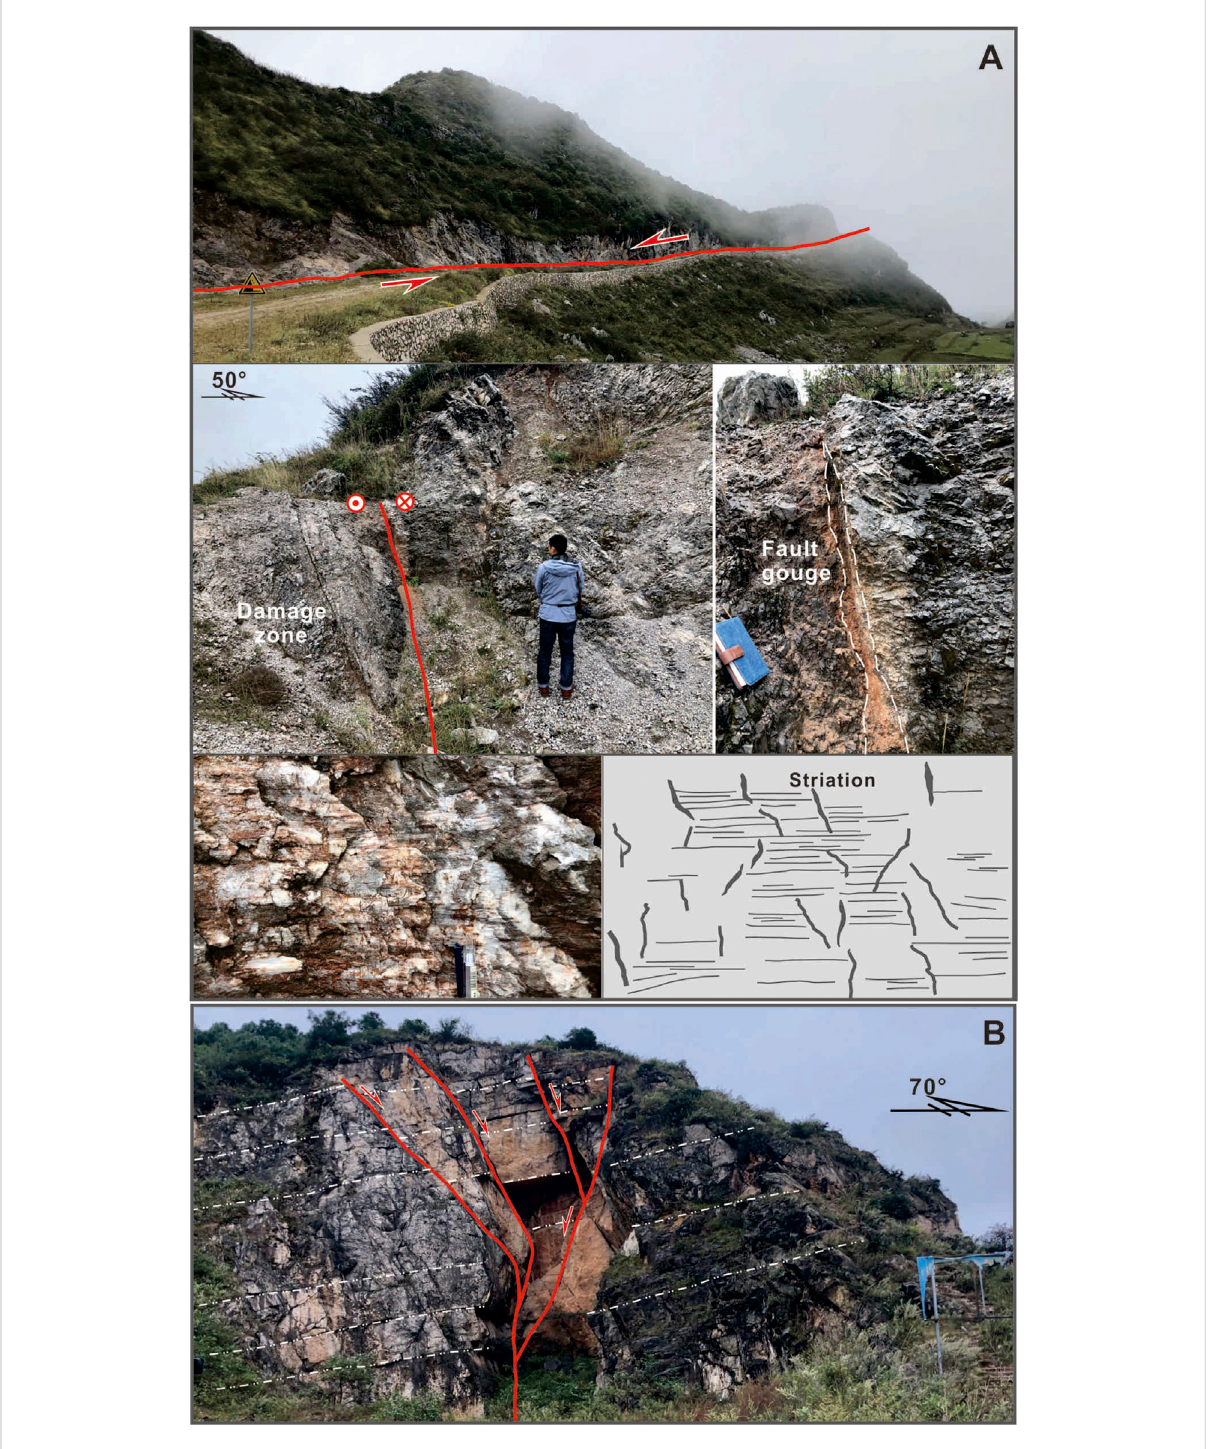
Typical deformation fabrics associated with sinistral strike-slip shearing. (A) Steeply dipping fault planes, sub-horizontals striations, and linear valleys indicate sinistral strike-slip movement. (B) A negative fl ower structure developed in the thick Carboniferous limestone of the Baizuo